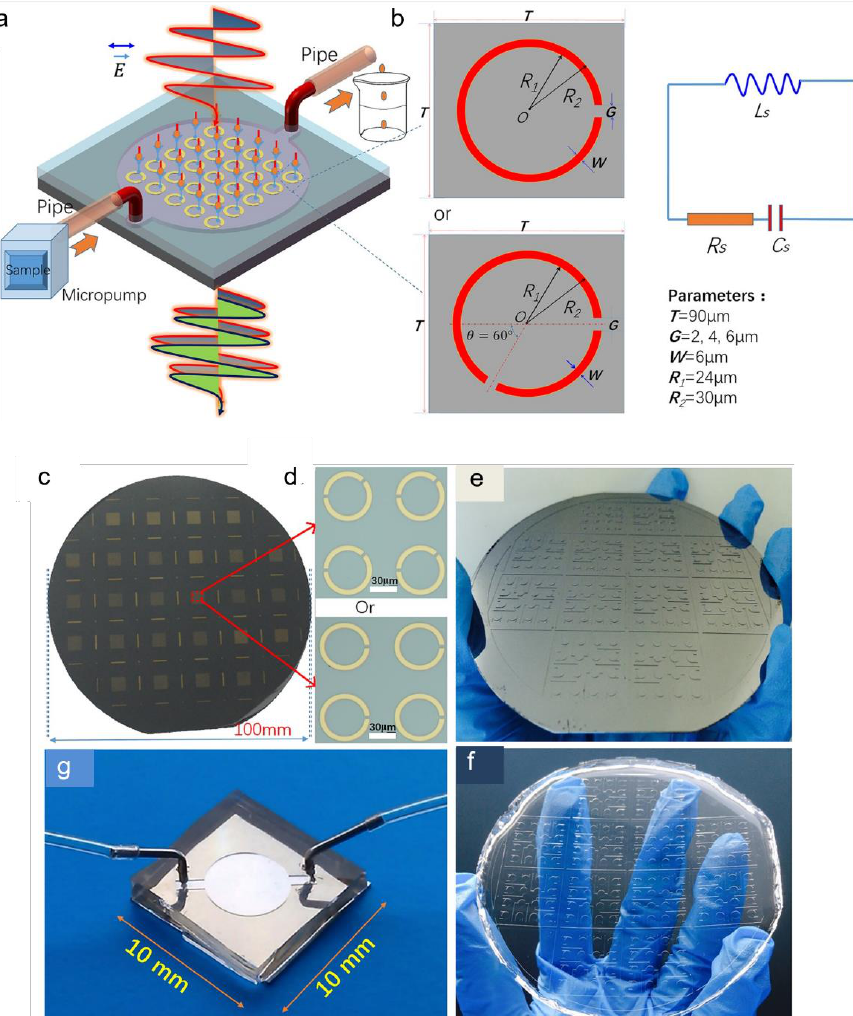
Figure 5. ( a ) The sketch of THz SRR biosensor integrated with a microfluidics chip. ( b ) RLC equiv- alent circuit of the SRR. ( c – g ) Fabrication steps of the microfluidics integrated SRRs. ( c ) SRRs on a 4-inch silicon wafer. ( d ) Four units of the SRR structure with one or two gaps. ( e ) The SU-8 mould for microfluidics chip fabrication. ( f ) PDMS microchannel. ( g ) The final biosensor chip integrated with microfluidics. © 2017 Springer Nature, Zhaoxin Geng, et al.